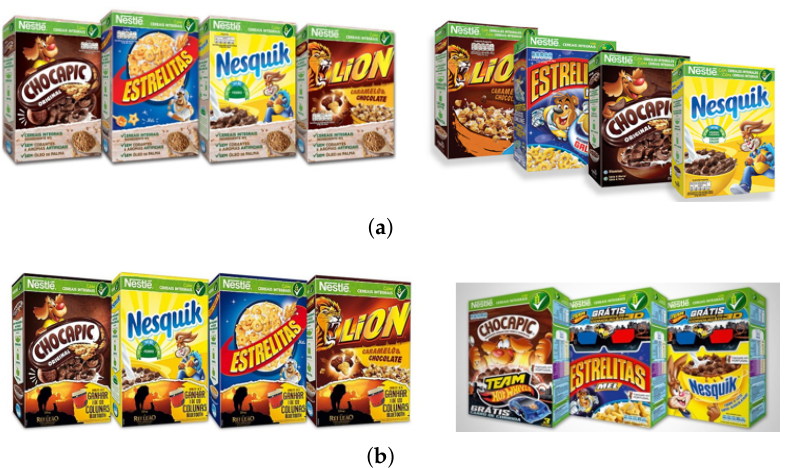
Figure 1. Illustration of differences introduced by marketing strategies, namely differences in flavours between same parent brands ( a ), and small variations in the packaging of the same product ( b ).